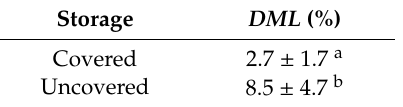
Table 2. Value of dry matter loss ( DML ) of different type of storage of P16 Eucalyptus woodchips, expressed as percentage (%). DML value with different letters indicate mean values significantly different (p < 0.05) according to the T-test.